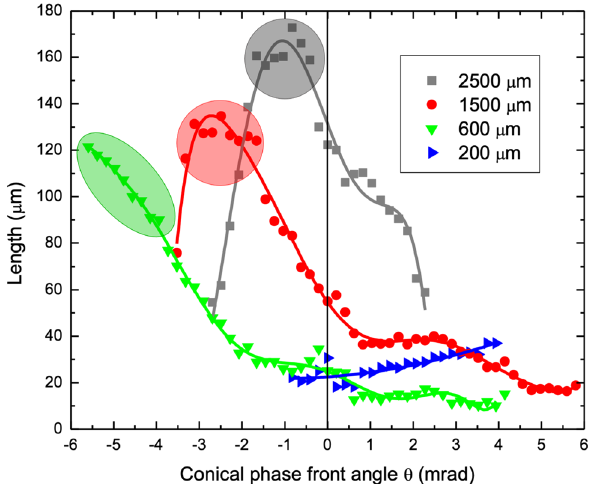
Figure 5. Influence of conical phase front on single-pulse filament length with increasing focal depth. Length of filament tracks formed by single pulses of 8 µJ energy, observed under varying conical phase front angles, θ , presented for 200, 600, 1500, and 2500 µm depth. The optimal zone for long and uniform filament tracks (oval or circle sections) follows an increasingly negative conical phase front with shallower focal depth. Minimum track lengths are generated with increasingly positive conical phase front angle as depth increases. Solid lines are a guide for the